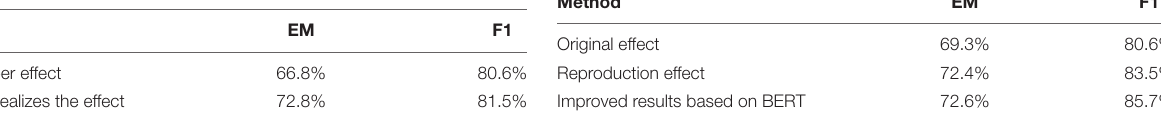
TABLE 1 | Baseline model evaluation results.